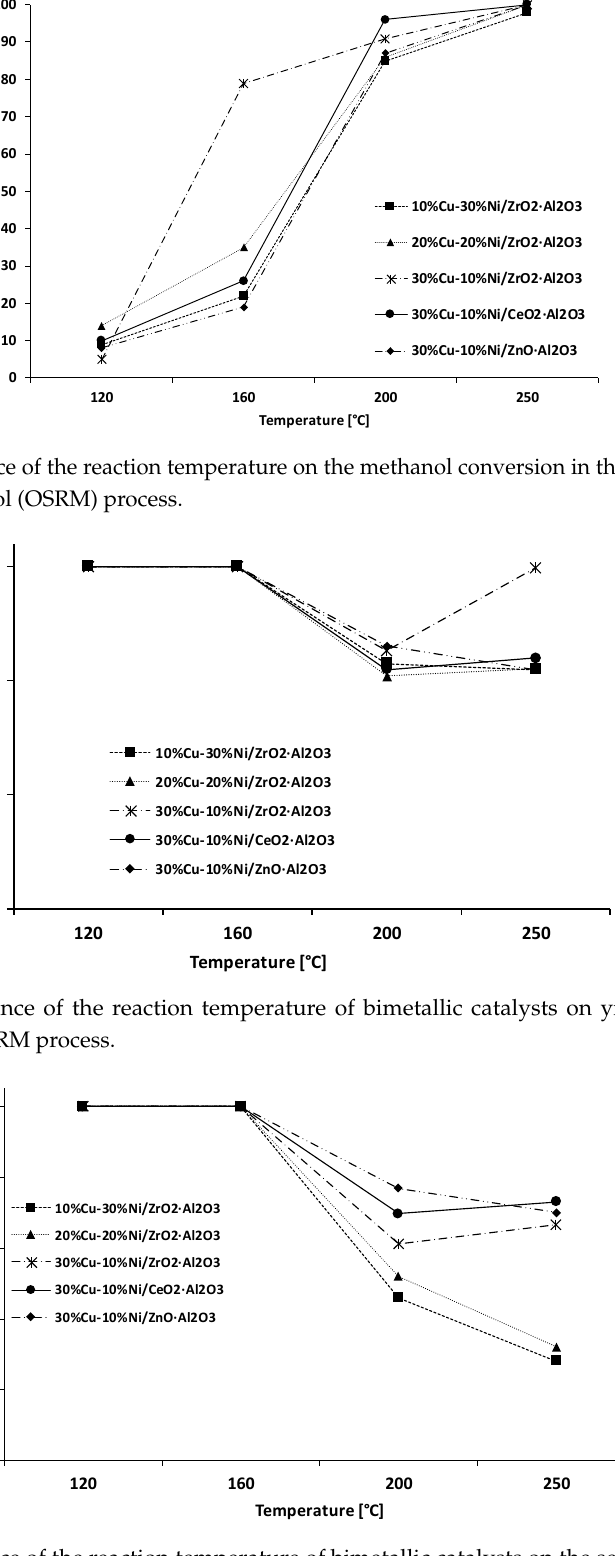
Figure 4. The influence of the reaction temperature of bimetallic catalysts on the selectivity towards CO formation in the OSRM process. In the next stage of this study, we determined the physicochemical properties of the investigated systems in order to correlate them with their catalytic activity in the OSRM process. The values of the specific surface area (SSA), monolayer capacity and average pore radius for all investigated supports and Cu-Ni catalysts are shown in Table 2. The results of the SSA measurements showed that the ZrO 2 ·Al 2 O 3 and ZnO·Al 2 O 3 supports had the same values of BET surface area and monolayer capacity equal 252 m 2 /g and 57.9 cm 3 /g, respectively. In the case of the CeO 2 ·Al 2 O 3 system, the values of the monolayer capacity and the specific surface area were significantly lower compared to other tested supports. In addition, all tested catalyst systems had average pore size in the range 2–2.5 nm. Introduction of copper and nickel oxides onto the support surface results in decrease in the specific surface area. This can be explained by the blocking of the support pores by the metal oxide phase introduced during the preparation process. Concerning the x Cu - y Ni/ZrO 2 ·Al 2 O 3 (where x (y) = 10, 20 and 30 wt.%) catalysts, the values of the BET surface area are in the range 119 – 142 m 2 /g. Furthermore, 20% Cu - 20% Ni/ZrO 2 ·Al 2 O 3 catalyst was distinguished by significantly higher values of the SSA and monolayer capacity of 142 m 2 /g and 32.7 cm 3 /g, respectively. On the other hand, the SSA measurements obtained for 30% Cu - 10% Ni catalysts supported on ZrO 2 ·Al 2 O 3 , ZnO·Al 2 O 3 and CeO 2 ·Al 2 O 3 allow to present the BET surface area and monolayer capacity of the catalysts by the following order: 30% Cu - 10% Ni/ZrO 2 ·Al 2 O 3 ≈ 30% Cu - 10% Ni/CeO 2 ·Al 2 O 3 > 30% Cu - 10% Ni/ZnO·Al 2 O 3 . It is worth mentioning, that 30% Cu - 10% Ni/ZrO 2 ·Al 2 O 3 and 30% Cu - 10%